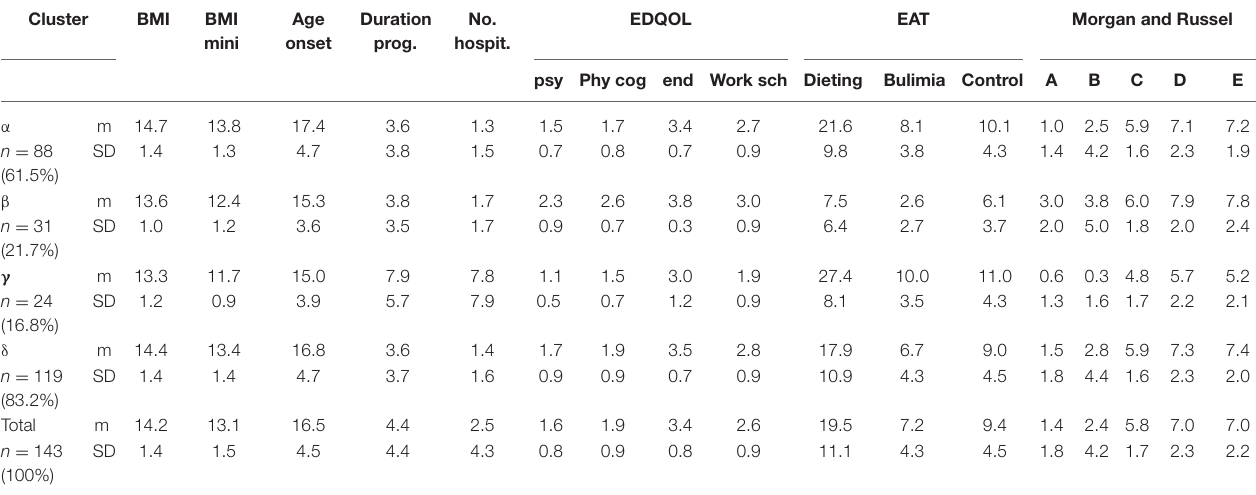
TABLE 4 | Averages of variables representing the clinical severity of AN based on clusters. Cluster BMI BMI Age Duration No. EDQOL EAT Morgan and Russel mini onset prog. hospit. psy Phy cog end Work sch Dieting Bulimia Control